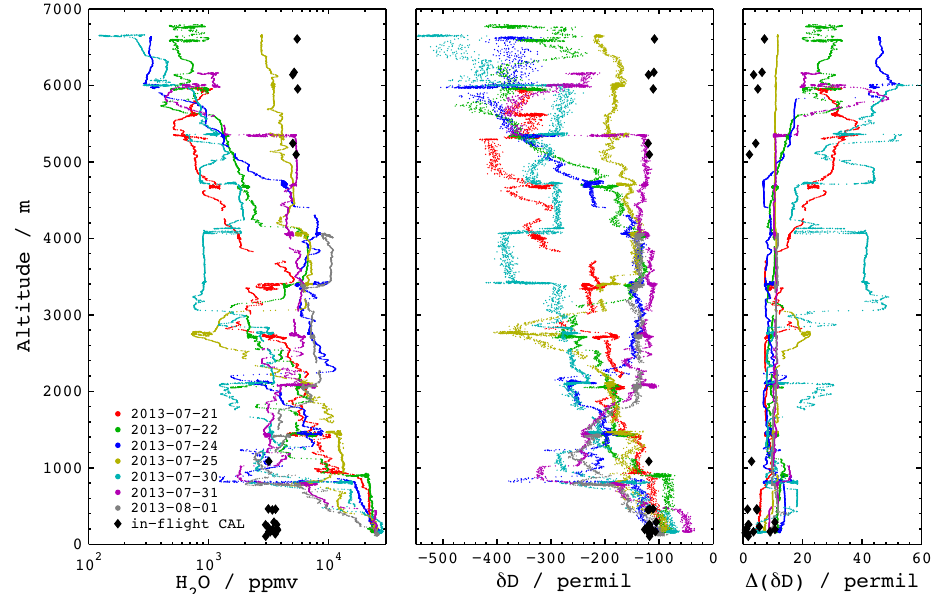
Figure 9. Vertical profiles of H 2 O (left), δ D (center), and instrumental absolute uncertainty (right) of all flight days evaluated at 1Hz. For better clarity we show here only data with aircraft descending. Black symbols denote the respective quantities of the inflight calibration-gas measurements.